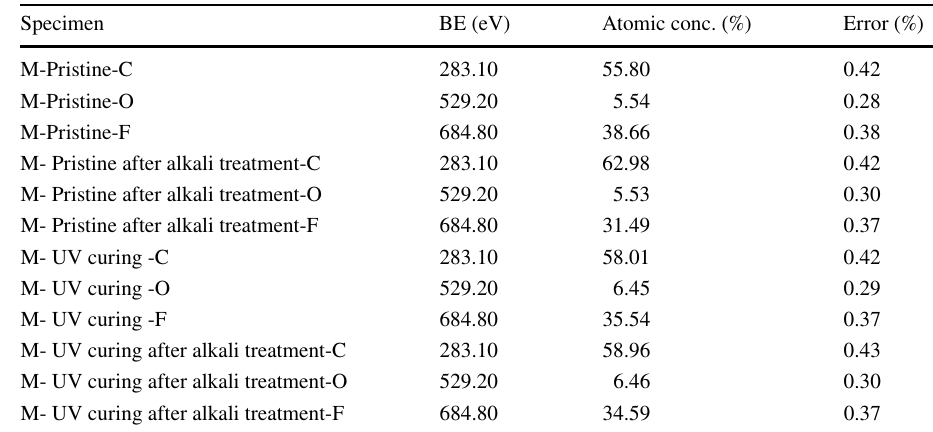
Table 3 The effect of NaOH treatment on element of PVDF membrane